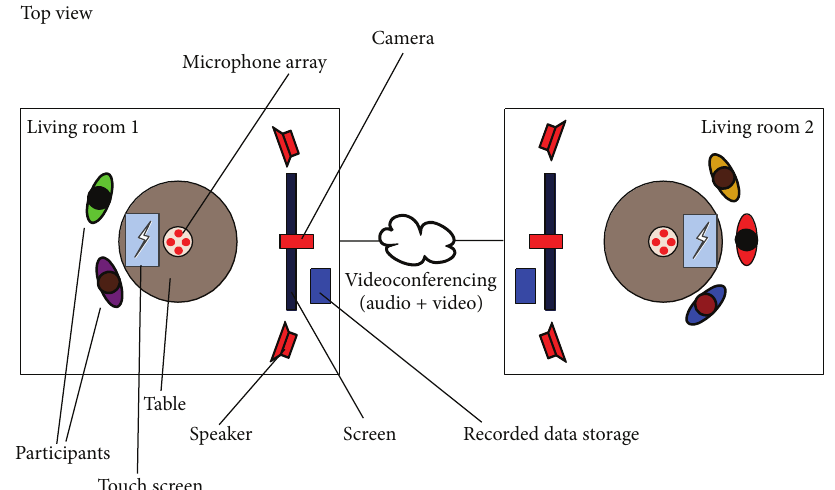
Figure 1: TA2 setup, view from top [36]. The audio and video sensors are spatially separated within a room: the microphone array is located above the table next to participants, while the camera is collocated with the wall screen for teleconferencing.